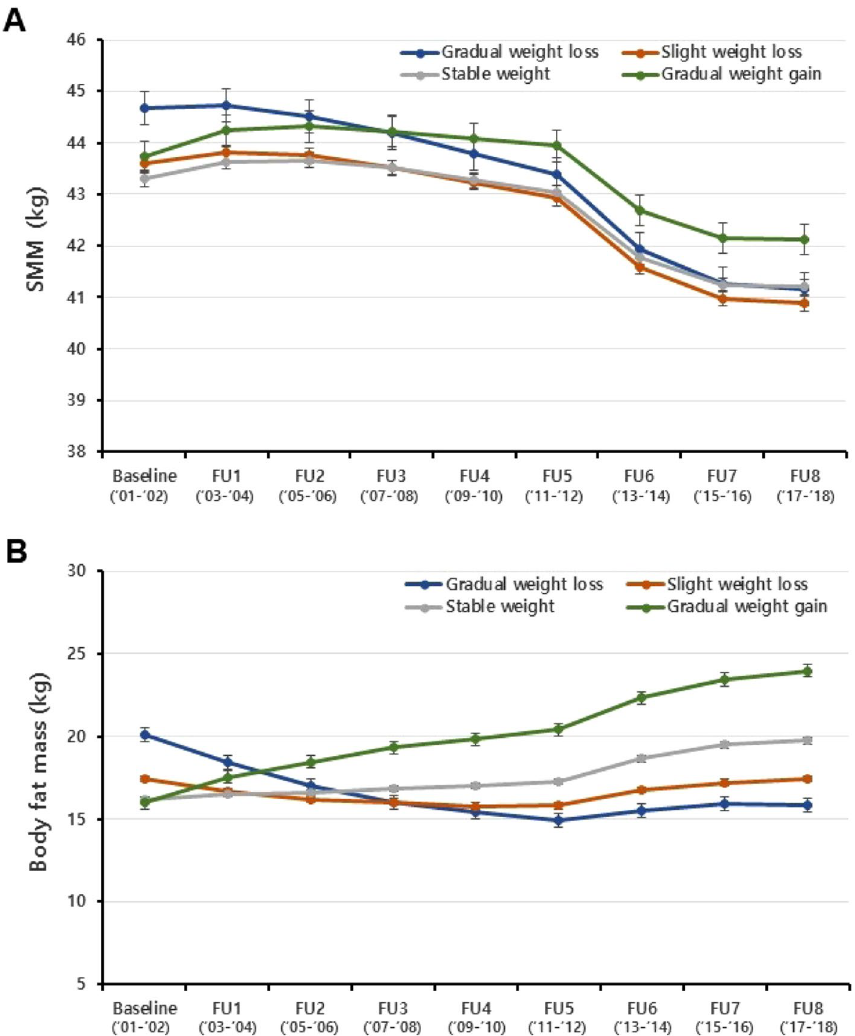
Figure 3. Changes in skeletal muscle mass and body fat mass among weight-trajectory groups. SMM Skeletal muscle mass, FU follow-up. ( A ) Changes in skeletal muscle mass among weight-trajectory groups, ( B )